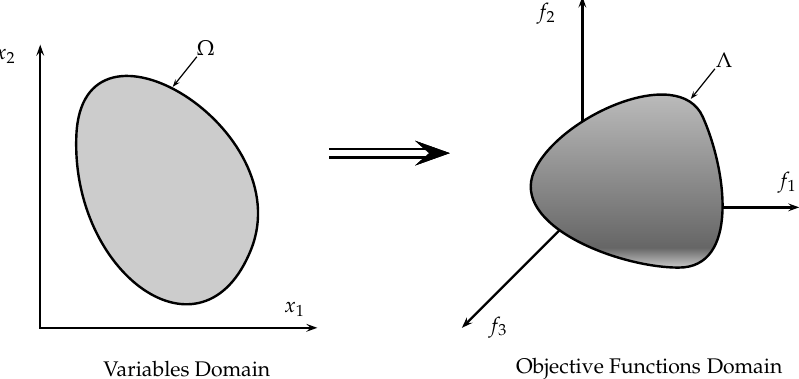
Figure 2. Domain of variables and objective functions.